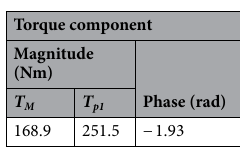
Table 2. Input torque profiles assuming the WOT condition on the